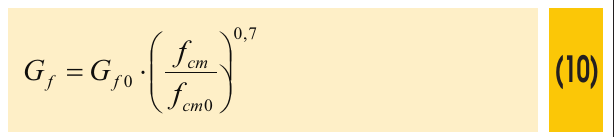
Displacements of slab